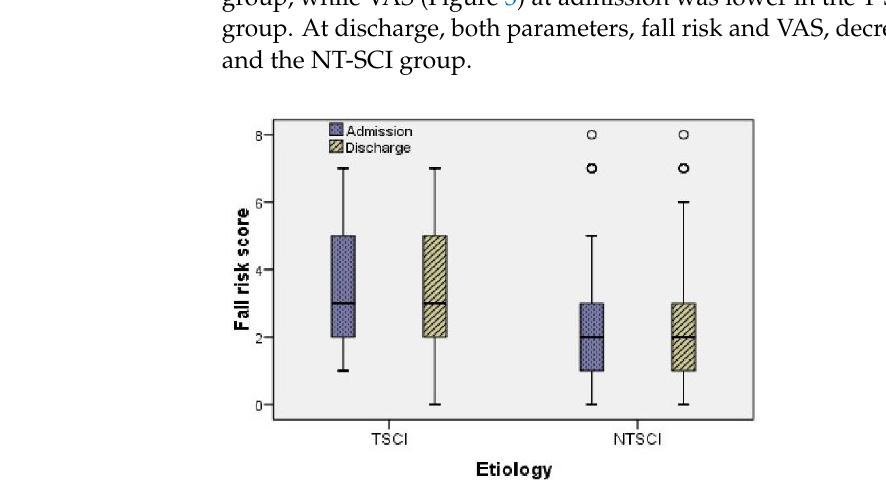
Figure 3. The distribution of VAS scores across categories of etiology (T-SCI/NT-SCI). Figure 4. The distribution of FIMm scores cross categories of etiology (T-SCI/NT-SCI).